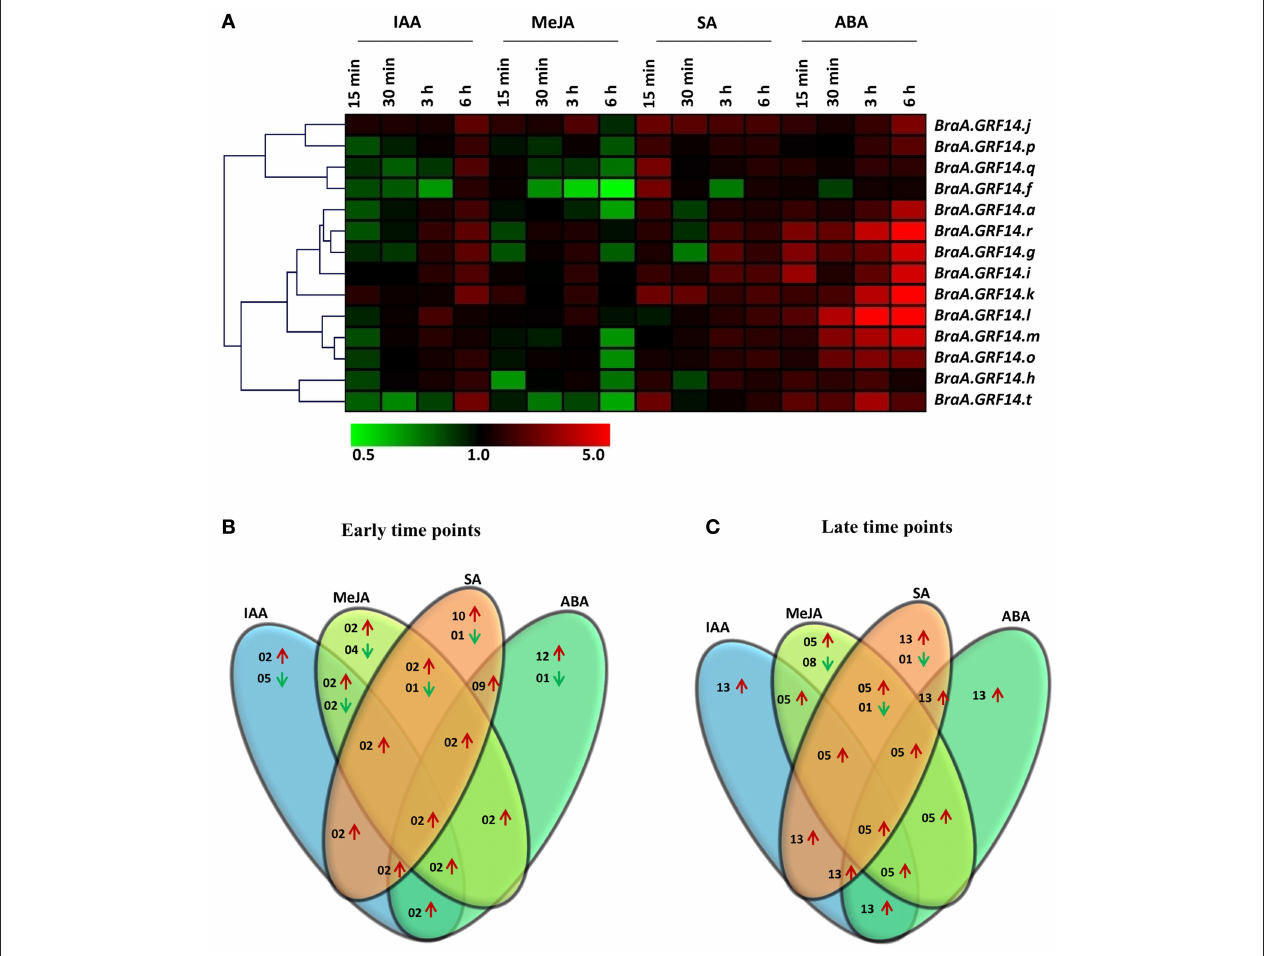
FIGURE 5 | Expression profile of BraA.GRF14 genes in 6 days old B. rapa seedlings in response to phytohormone treatments. (A) A heat map representing hierarchical clustering of average fold change of BraA.GRF14 genes expression in response to methyl jasmonate (MeJA, 0.2mM), salicylic acid (SA, 0.2mM), 1-aminocyclopropane carboxylate (ACC, 0.1mM), indole-3-acetic acid (IAA, 0.1mM), and abscisic acid (ABA, 0.1mM) at different time points (15, 30min, 3 and 6h) is shown (mentioned at the top of each lane). The mock treated seedlings of same time interval served as control (set at 1) and expression was normalized with ACT2 gene. The color scale representing average signal is shown at the bottom of the heat map. The Venn diagrams represent the total number of BraA.GRF14 genes which were upregulated (red upward arrow) and down-regulated (green downward arrow) during (B) early (15 and 30min), and (C) late (3 and 6h) phytohormone